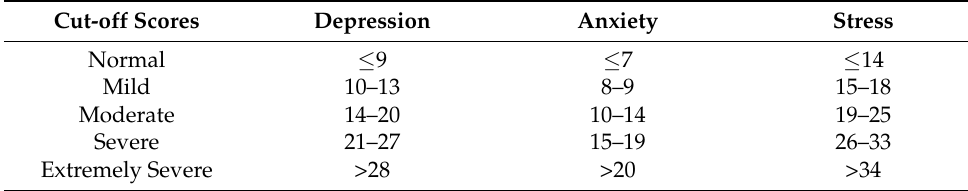
Table 1. Depression, Anxiety, and Stress Severity cut-off